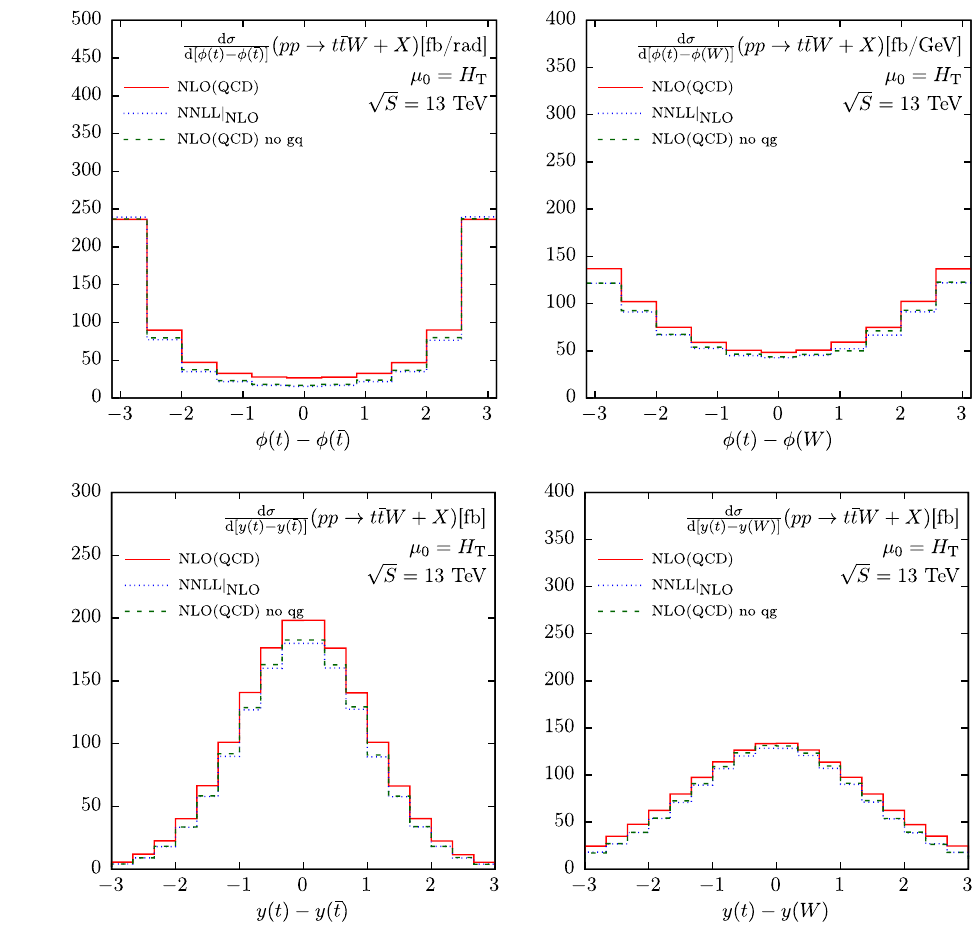
Fig. 8 The same as in Fig. 6 but for the pp → t ¯ tW